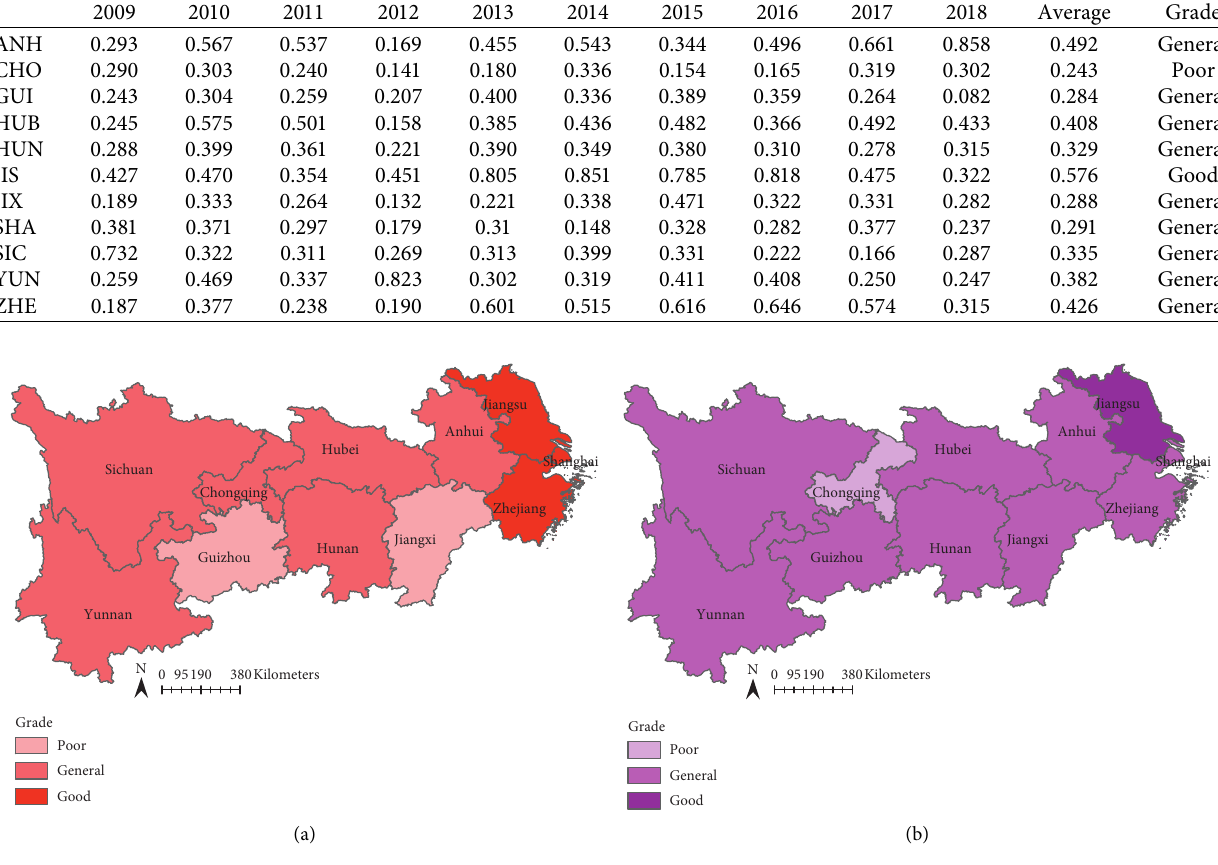
Figure 4: Spatial distribution of CDD: (a) finance CDD; (b) air environment